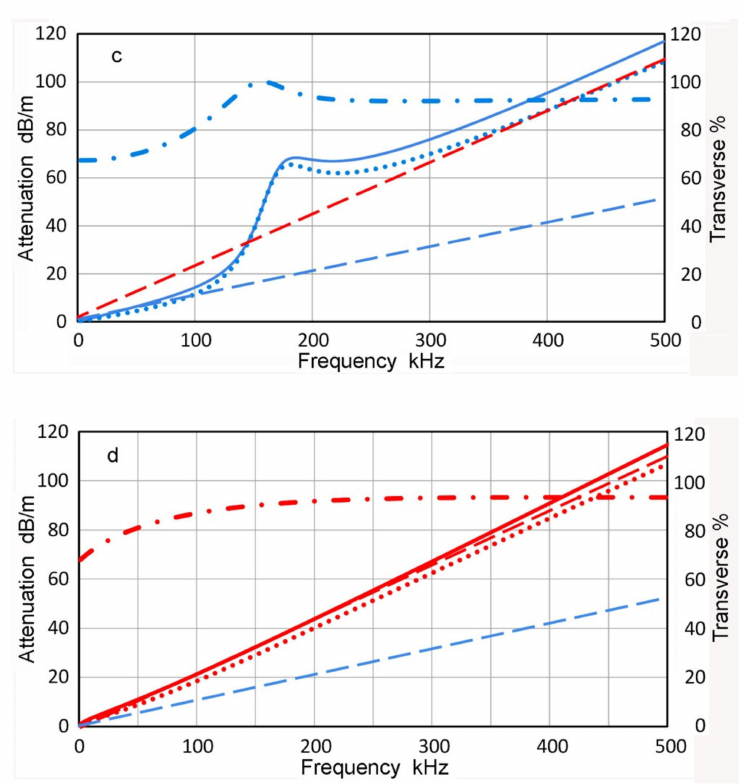
Figure 4. ( a ) Theoretical calculations of Lamb wave attenuation from Viktorov [19] and Disperse program [25,51] for an isotropic Al plate (6.4-mm thickness) with Poisson’s ratio of 0.34. α –S o : Solid blue curve for Viktorov with its transverse attenuation component shown by dashed green curve. Dotted blue curve for Disperse. α –A o : Solid red curve for Viktorov with its transverse attenuation component shown by dashed purple curve. Dotted red curve for Disperse. α L and α T : Blue and red long-dash lines. ( b ) Same as in ( a ). α –S 1 : Solid blue curve for Viktorov. Dotted blue curve for Disperse. α –A 1 : Solid red curve for Viktorov. Dotted red curve for Disperse. ( c ). Theoretical calculations of Lamb wave attenuation using Disperse [25,51] for an isotropic Al-1100 plate (6.4-mm thickness, but higher α L and α T ). Solid blue curve for α –S o with its transverse attenuation component shown by dotted blue curve. Blue dash-dotted curve is percent contribution of transverse attenuation component to α –S o , obtained by the parametric method (right scale). α L and α T : Blue and red dash lines. ( d ) Theoretical calculations of Lamb wave attenuation using Disperse [25,51] for an isotropic Al-1100 plate (6.4-mm thickness, but higher α L and α T ). Solid red curve for α –A o with its transverse attenuation component shown by dotted red curve. Red dash-dotted curve is percent contribution of transverse attenuation component to α –A o , obtained by the parametric method (right scale). α L and α T : Blue and red dash